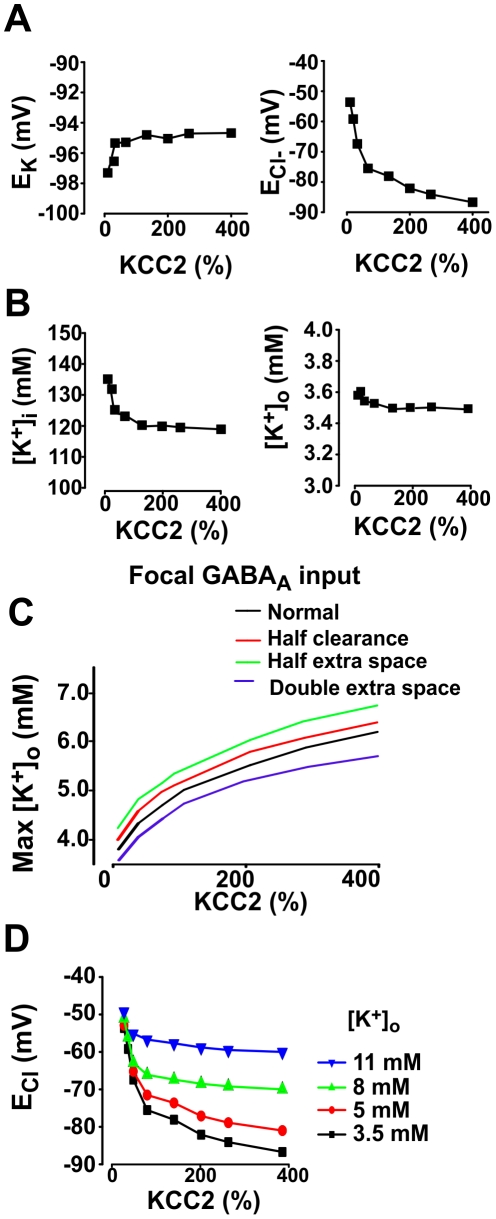
Interactions between [Cl−] regulation and [K+] regulation.
A. Variation of KCC2 levels caused sizeable shifts in E
Cl (right panel) but had negligible effects on E
K (left panel). Background synaptic activity was f
exc  =  0.2 Hz and f
inh  =  0.8 Hz. B. Intra- and extracellular concentrations of K+ for same simulations reported in A. Although extracellular K+ levels are low, [K+]o remains relatively stable due to other mechanisms, e.g. extracellular diffusion. This explains why E
K remains relatively constant in A. C. Maximal [K+]o reached by applying a 500 nS GABA conductance to a dendrite. Time constant for diffusion from the FH space was tested at 100 and 200 ms (which corresponds to normal and 50% slower extracellular K+ clearance) as well as with variable extracellular space. D. E
Cl as a function of the mean frequency of inhibitory input for various fixed levels of [K+]o.